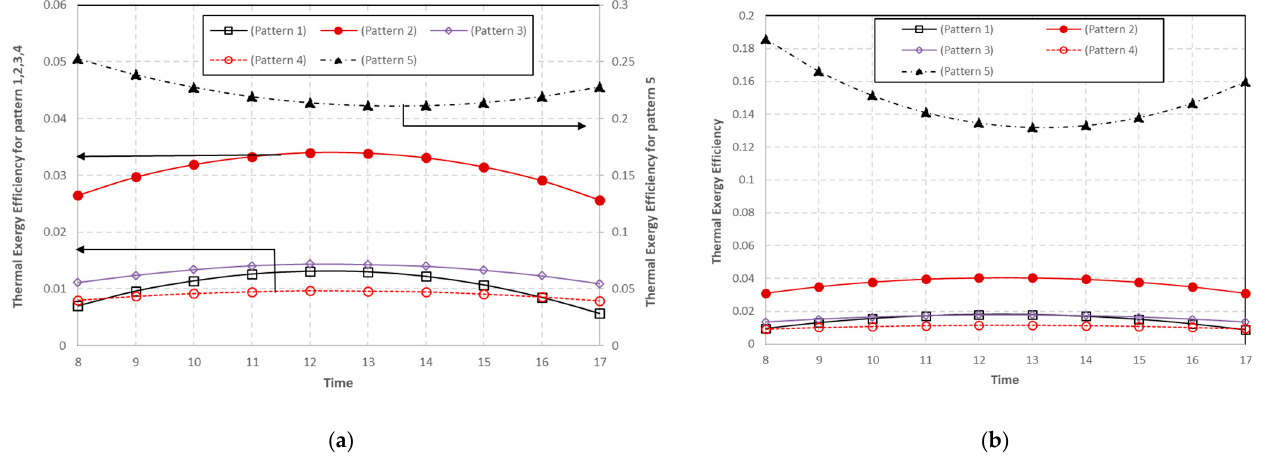
Figure 17. Hourly variations in efficiency of thermal exergy for different configurations. ( a ) during Winter day ( b ) during Summer day.